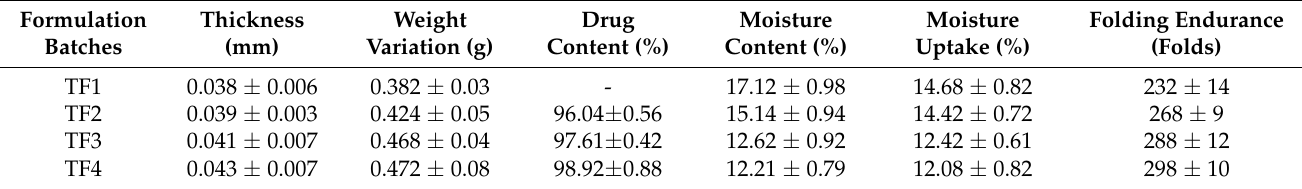
Table 3. Physicochemical evaluation of transdermal films.